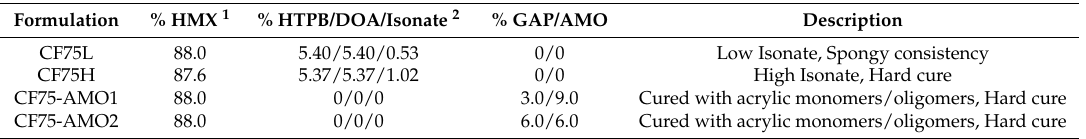
Table 1. HMX formulations prepared and tested.